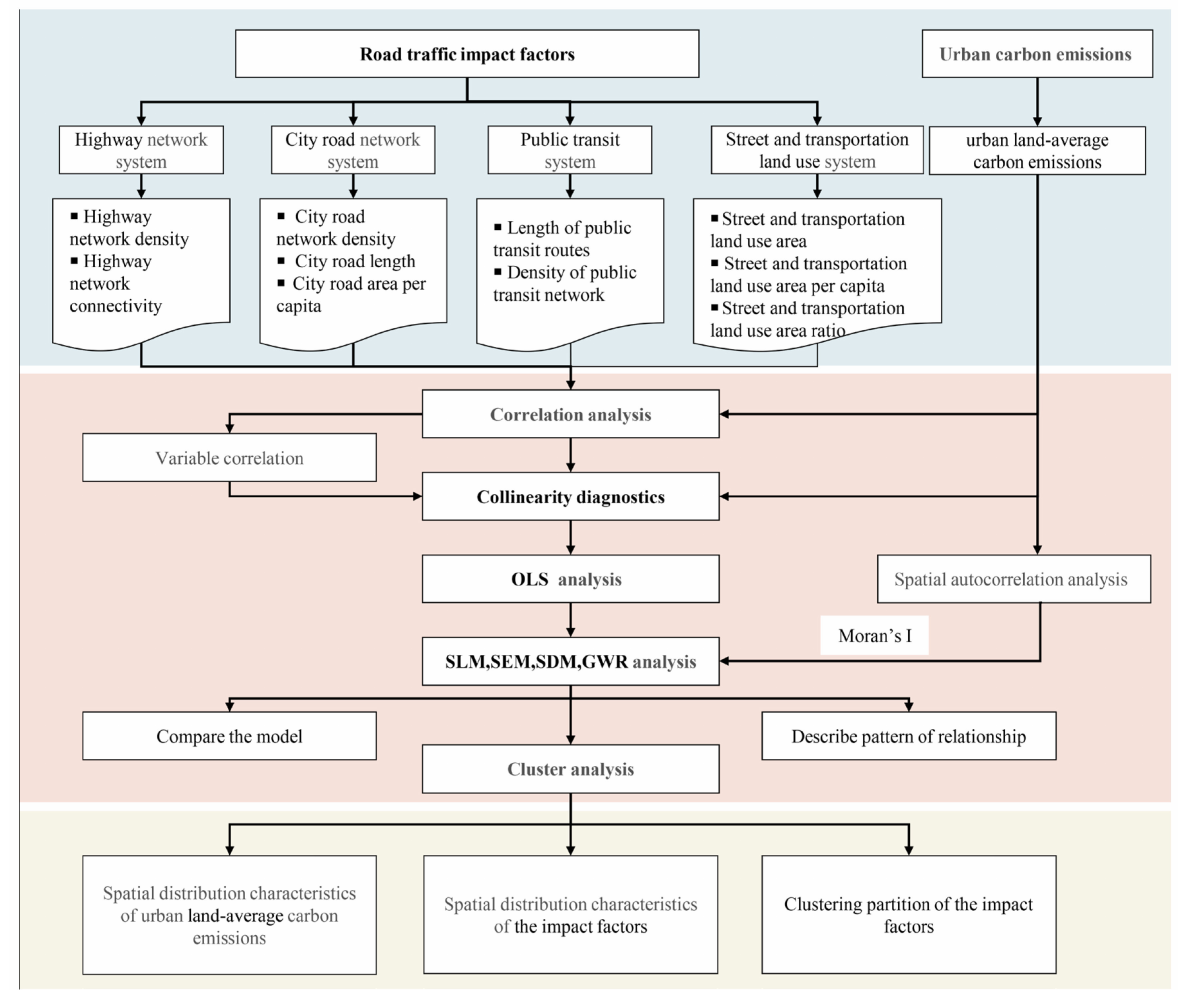
Figure 3. Research